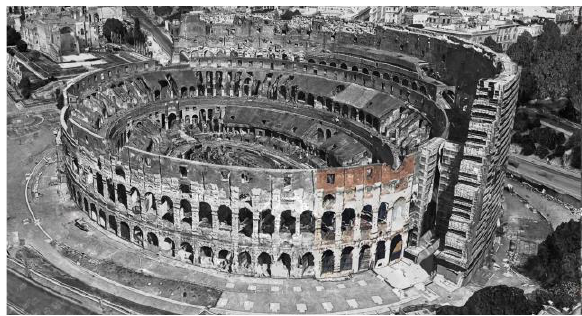
Figure 1. Photo of the eastern entrance of the Flavian Amphitheatre, in which the portion analysed is highlighted. Figure 2. 3D model made of cork by Carlo Lucangeli. In red the six columns, arranged in two storeys, under study are highlighted (Image taken from (Coarelli, 1999) p. 217).